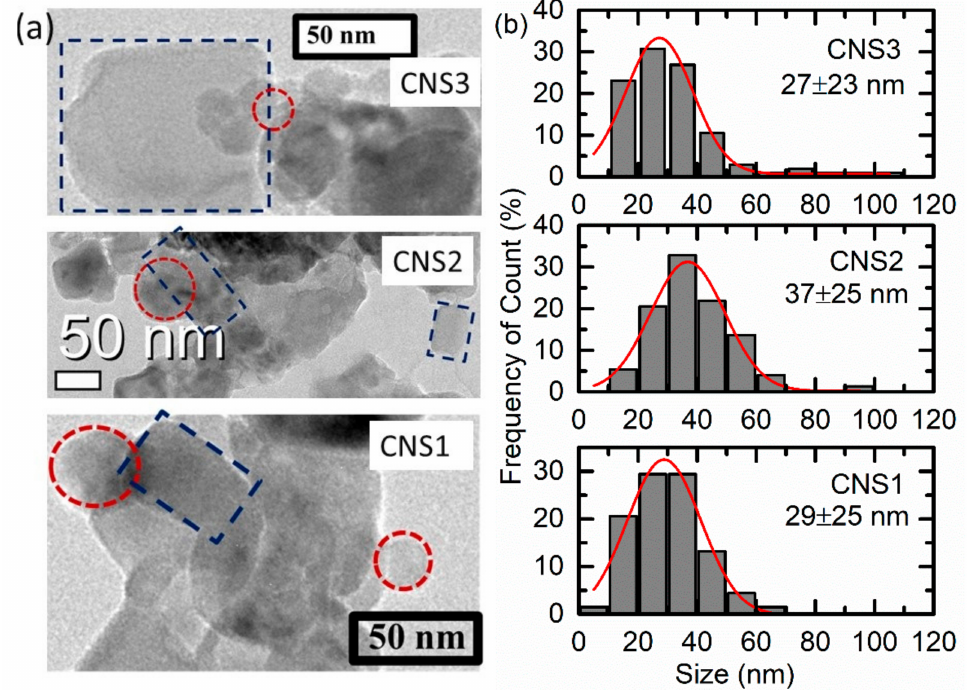
Figure 4. ( a ) Shape overview, and ( b ) size distribution of CNS1, CNS2, and CNS3. Selected area diffraction (SAD) patterns of CNS1, CNS2 and CNS3 are shown in Figure 5. Ring-like patterns are observed in the SAD patterns of all nanocrystals. This is associated with the polycrystalline nature of grown crystals, which is consistent with the results obtained from the XRD study (Figure 2). Rings corresponding to (012), (104), (110), (11–3), and (202) crystal planes are mentioned in the SAD